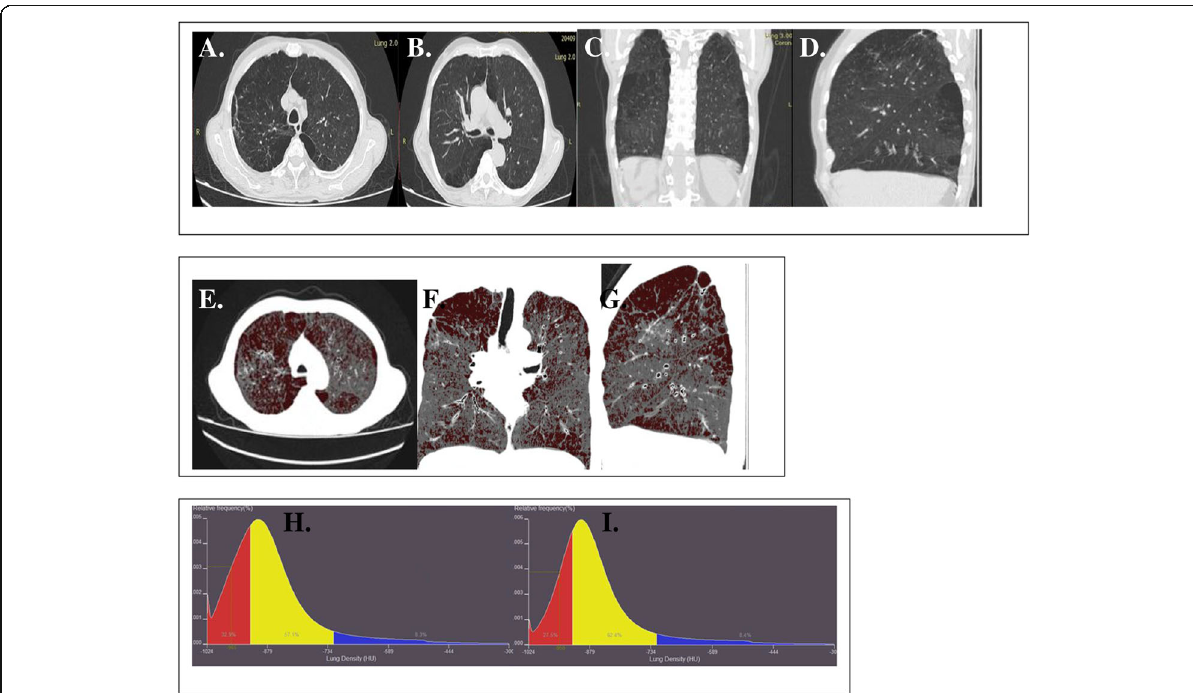
Fig. 1 Male patient 65 years old, chronic heavy smoker. Pulmonary function tests showed very severe obstructive pulmonary disease. a – d HRCT (axial, sagittal, and coronal images) revealed hyperinflated chest, mild bilateral diffuse emphysematous changes predominately the right upper lobe. e – g Images after applying density mask revealed emphysematous areas as black areas while normal lung density as gray. More pronounced bilateral diffuse emphysematous changes, more evident at the right upper lobe (Right upper lobe low density index 48.4%) and to a lesser degree, left upper lobe (left upper lobe low density index 33.1%). h , i Lung density histogram showing distribution of voxel density with respect to the whole lung volume: x -axis represents density range expressed in HU, whereas y -axis scales the relative number of voxels as a percentage of total lung volume. Evaluation of the histogram allowed quantification mean lung density (MLD), 15% percentile value (P15), and relative volume of parenchyma with density lower than – 950 HU. LAV, low attenuation volume. PD15% for right lung is 59, left lung 74, and both lungs 66. N.B: both upper lobes more emphysematous than both lower lobes as regarding the low-density index that of both upper lobes was 41.2%while that of both lower lobes was